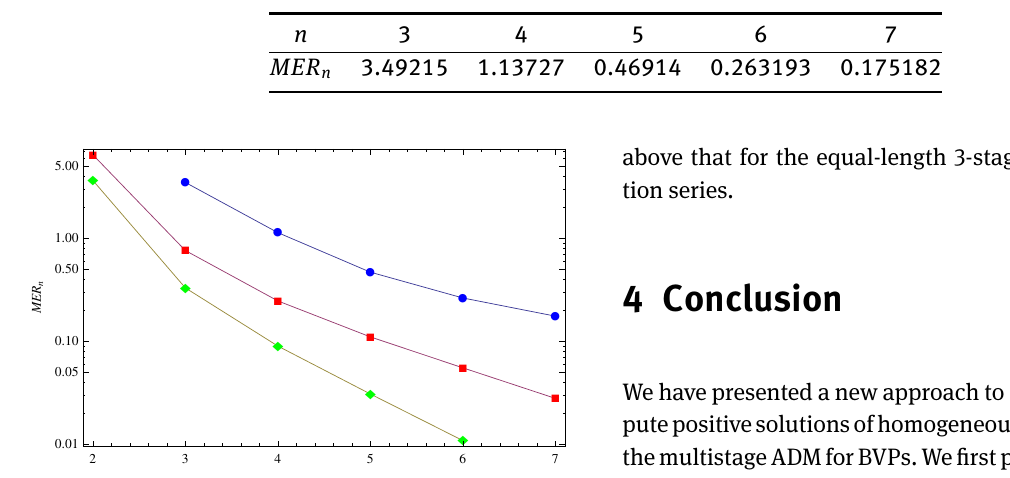
Table 8: The maximal error remainder parameter MER n for n = 3, 4, 5, 6, 7 .